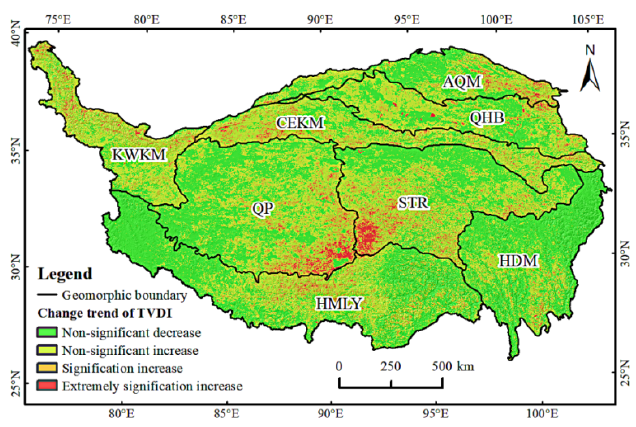
Figure 8. Trend of TVDI in the QTP. Figure 8. TVDI trends in